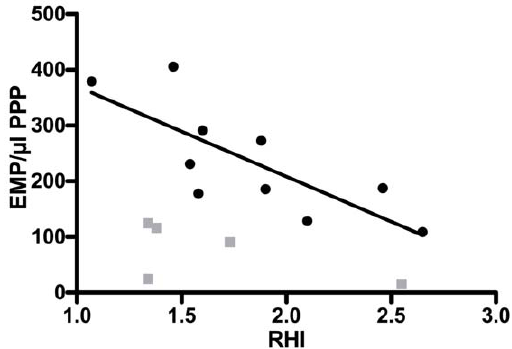
Figure 5. In healthy volunteers the inverse relation of EMP with RHI is confounded by the intravenous administration of a pure lipid solution. 5 healthy volunteers were evaluated on 3 different study days. Day A: blood was collected after an overnight fast and PAT was performed. EMP were detected by flow cytometry as particles , 1 m m and CD31 + /CD42b 2 in PPP. Day B: a NaCl 0.9% infusion was administered in fasting conditions and the same measurements as on day A were performed. Day C: the same protocol was used as on day B, but a parenteral lipid emulsion was infused instead of NaCl. On day A and B (black dots) there was an inverse relation between EMP numbers/ m l PPP and RHI (r= 2 0.758, p=0.011 combining data from day A and day B). This relation was confounded by lipid infusion as on day C (gray quadrangles) (r= 2 0.254, p=0.361 combining all data). EMP=endothe- lial microparticles, PAT=peripheral arterial tonometry, PPP=platelet poor plasma, RHI=reactive hyperemia index.